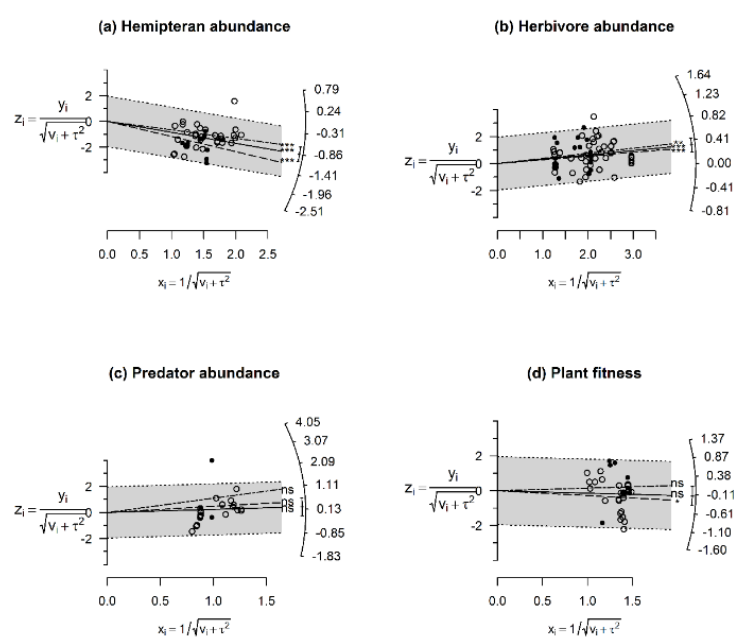
Figure 2. A radial plot of Hedges’ g obtained from invasive vs. native ant exclusion on ( a ) hemipteran abundance of 43 studies, ( b ) herbivores abundance of 62 studies, ( c ) predator/parasitoids abundance of 50 studies, and ( d ) plant fitness of 34 studies, all for random-effects model. These are scatter plots of standardized estimates z i against precisions x i , where y i and v i are Hedges’ g and standard deviation for each study, and τ 2 represents the variance of global standardized mean difference (SMD). Circles represent Hedges’ g of native ants, and dots are the invasive ants. The straight line projected from (0,0) onto the arc indicates the value of the global SMD, areas between the dotted line give the 95% confidence interval. The dashed line projects the SMD of native ants, the dash-dot line the SMD of invasive ants. * p < 0.05, ** p < 0.01, *** p < 0.001, “ns” not significant. The null hypotheses here are that the effects size equal zero.